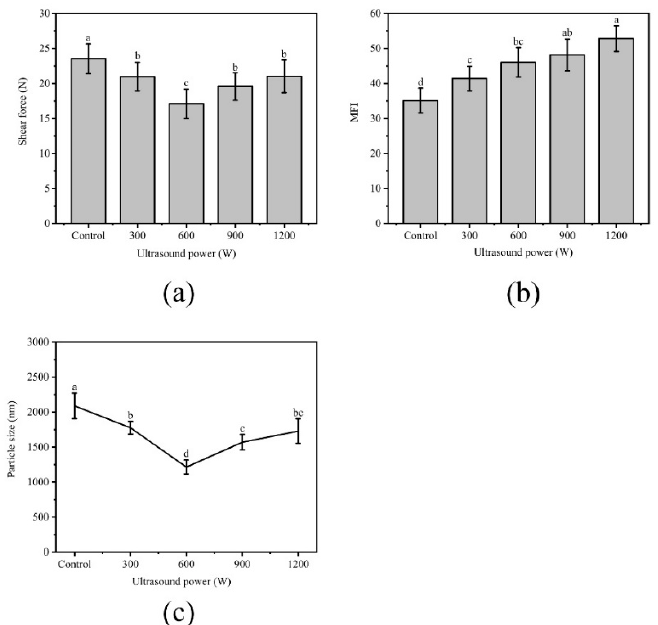
Figure 4. ( a ): Effect of different ultrasound power on shear force of WB; ( b ): Effect of different ultrasound power on the myofibril fragmentation index (MFI) of WB; ( c ): Effect of different ultrasound power on particle size of WB. Error bars are standard deviations (n = 5). Different letters above columns represent a significant difference at p < 0.05.